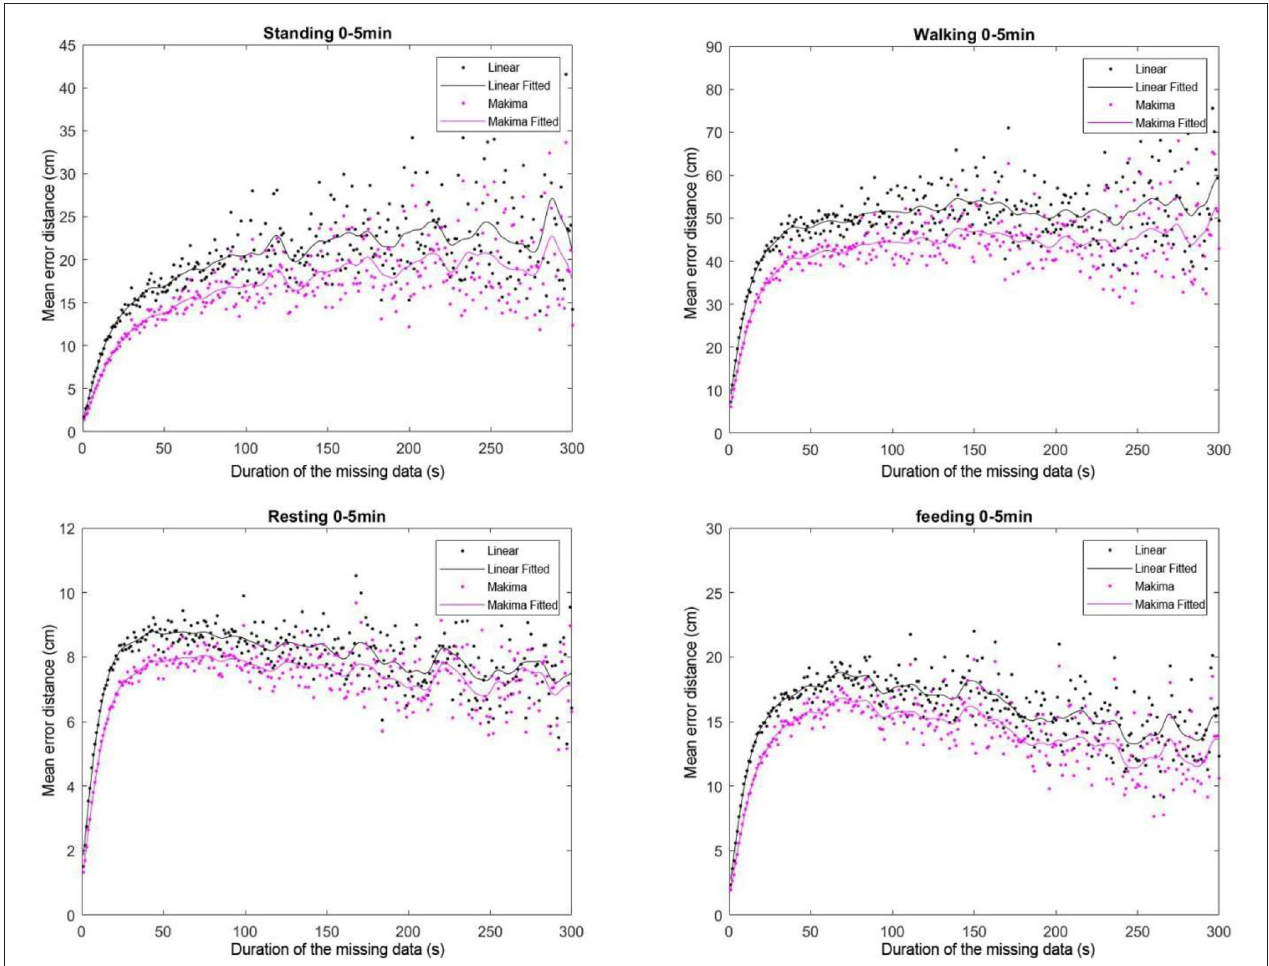
FIGURE 6 | Development of mean error distance with the duration of the missing data for the four recorded activities. Linear interpolation (black) and modified Akima interpolation (pink) were compared for missing values up to 300s. Using modified Akima interpolation, the mean error distances stabilized at lower levels than linear interpolation for all four